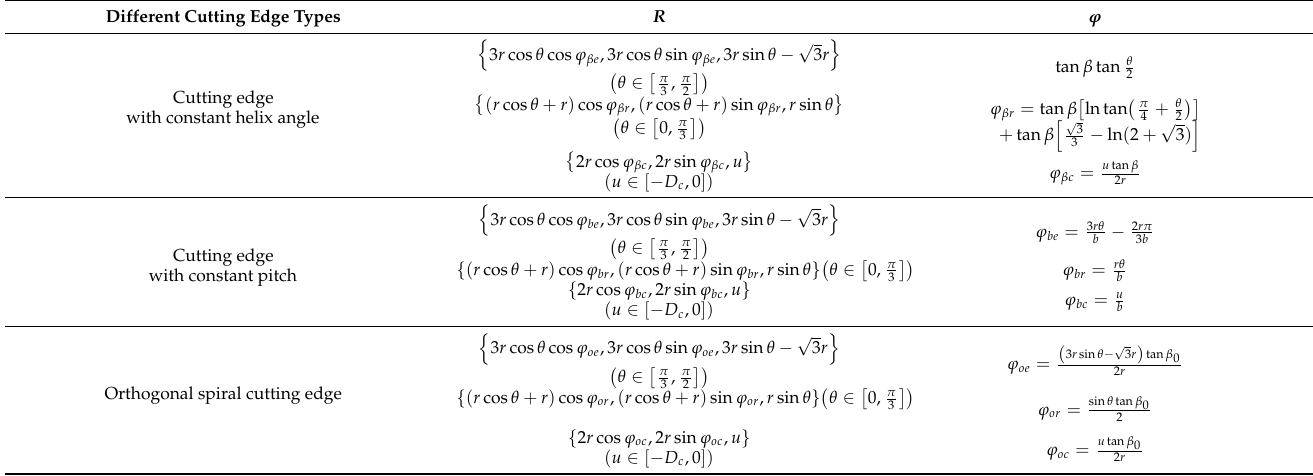
Table 1. Three types of cutting edge curves of